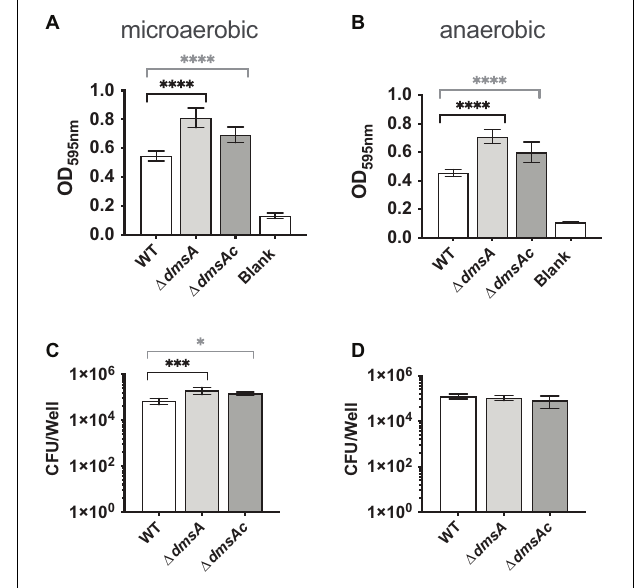
FIGURE 3 | Biofilm formation (A,B) and survival (C,D) of Hi2019 WT , Hi2019 (cid:49) dmsA , and Hi2019 (cid:49) dmsAc under microaerobic and anaerobic conditions. Biofilm formation was determined following staining with crystal violet. Culturable CFU present in the biofilm were determined following digestion of the biofilm matrix and serial dilution of vigorously resuspended bacteria. Statistical analyses used one-way ANOVA ( post hoc test: